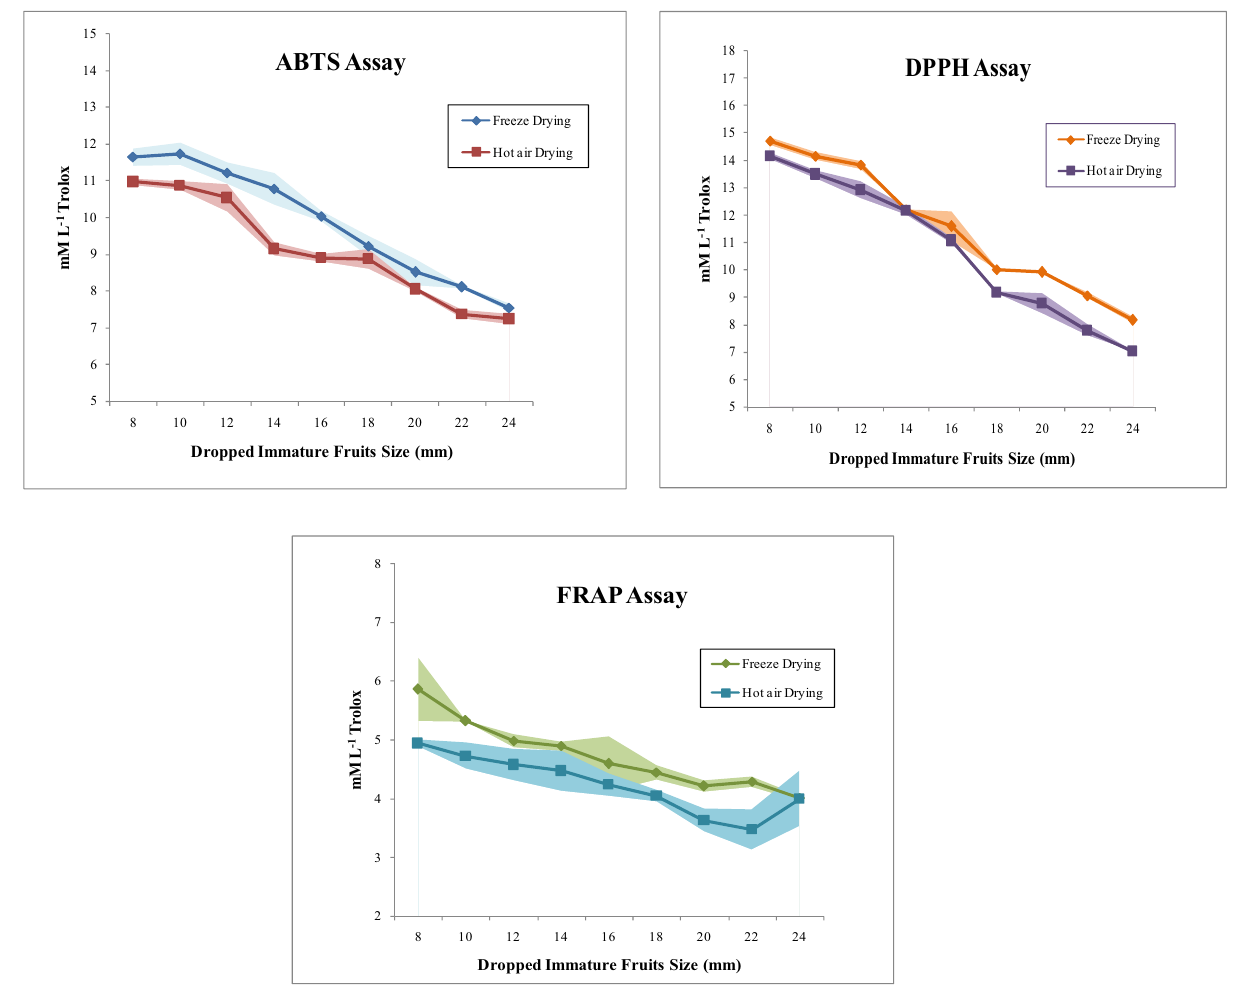
Figure 5. Antioxidant radical scavenging capacity by ABTS, DPPH and FRAP assays of freeze dried and hot air oven dried samples of immature C. sinensis L. Osbeck dropped